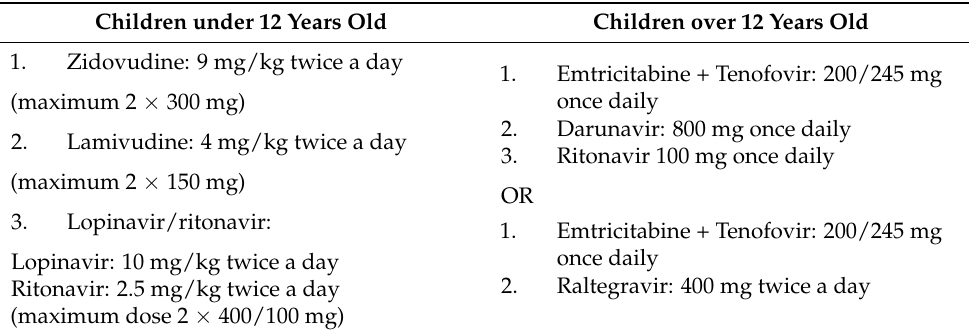
Table 6. Postexposure prophylaxis—first choice ARV drug regimens for pediatric patients according to recommendations of the Polish AIDS Society [36].